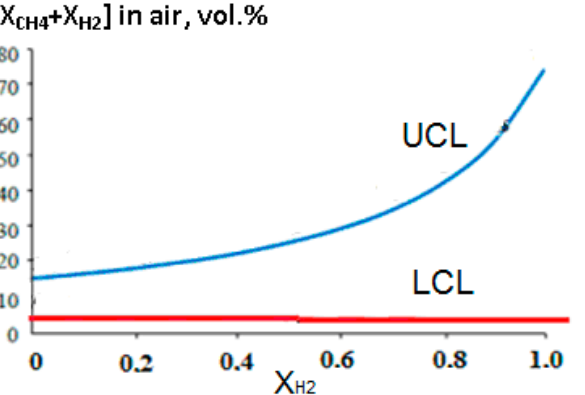
Figure 11. Dependence of the upper (UCL) and lower (LCL) concentration limits of flame propaga- tion in air on the volume fraction of hydrogen in the methane–hydrogen mixture.